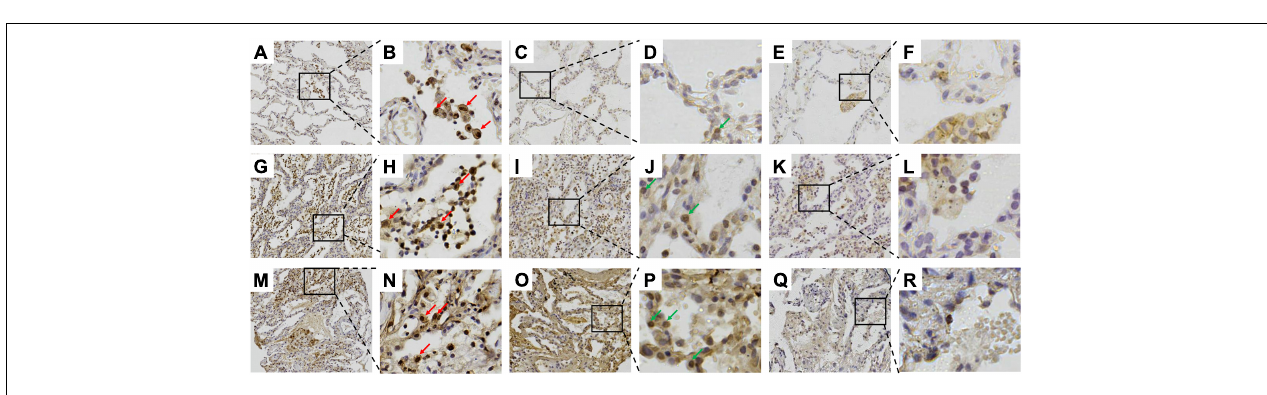
FIGURE 4 | Immunohistochemical staining of galectin-9 (Gal-9) in lung sections. (A–F) Surviving 39-year-old female patient with anti-melanoma differentiation-associated gene 5 (MDA5)-positive dermatomyositis (DM) with no interstitial lung disease (ILD). (G–L) Surviving 27-year-old male patient with anti-MDA5-positive DM with non-RP-ILD. (M–R) Non-surviving 55-year-old male patient with anti-MDA5-positive DM with RP-ILD. (A,B,G,H,M,N) Staining with anti-Gal-9 antibody. (C,D,I,J,O,P) Staining with anti-T-cell immunoglobulin mucin (Tim)-3 antibody. (E,F,K,L,Q,R) Staining with anti-CD44 antibody. The red arrows indicate Gal-9-expressing macrophages. The green arrows indicate Tim-3-expressing alveolar epithelial